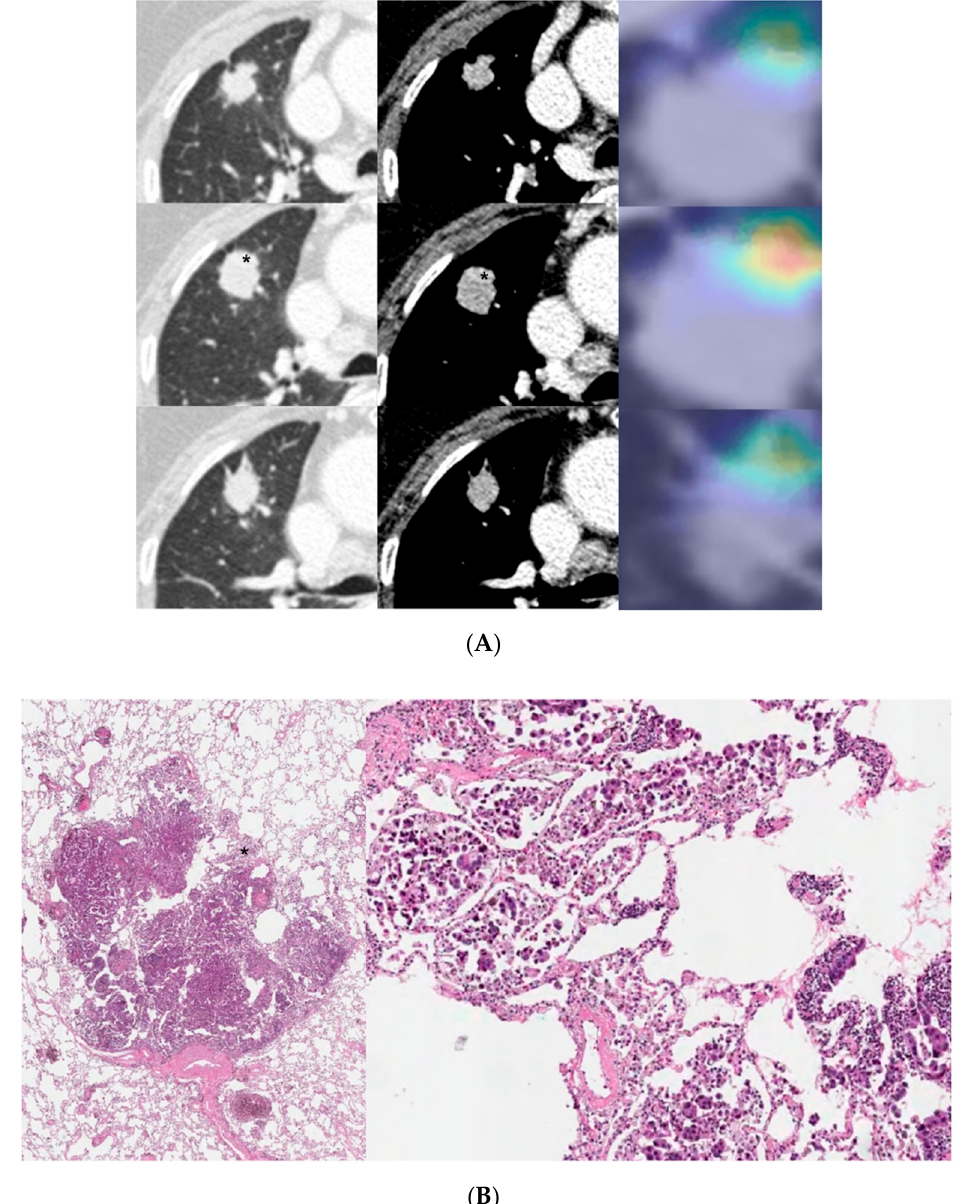
Figure 5. An 81-year-old male with invasive lung adenocarcinoma (Acinar 88.3%, MP 5.6%, Scar 6.1%). ( A ) A 21 mm lobulated enhancing nodule is noted in the right upper lobe. The activation map is shown as a heatmap, highlighting the most important region (marked with an asterisk) when it classified the given lesion as MPSol (micropapillary or solid pattern). The focal highlighted region is noted on the anteromedial side of the tumor. ( B ) Surgical pathology demonstrates a focal micropapillary pattern (marked with an asterisk) on the anteromedial side of the tumor with background of an acinar pattern, which corresponds to the activation map.